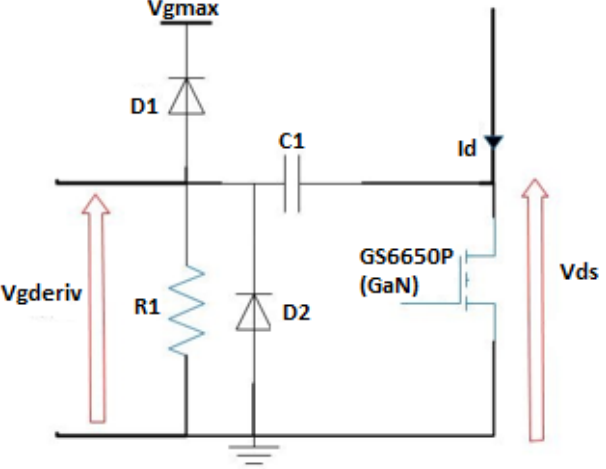
Figure 18. Schematic diagram of a derivative circuit.